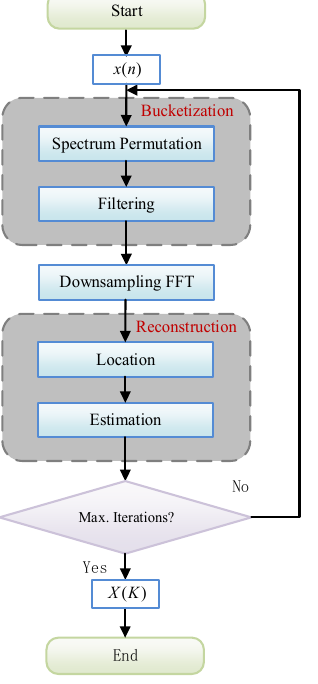
Figure 4. The flowchart of the SFFT algorithm.